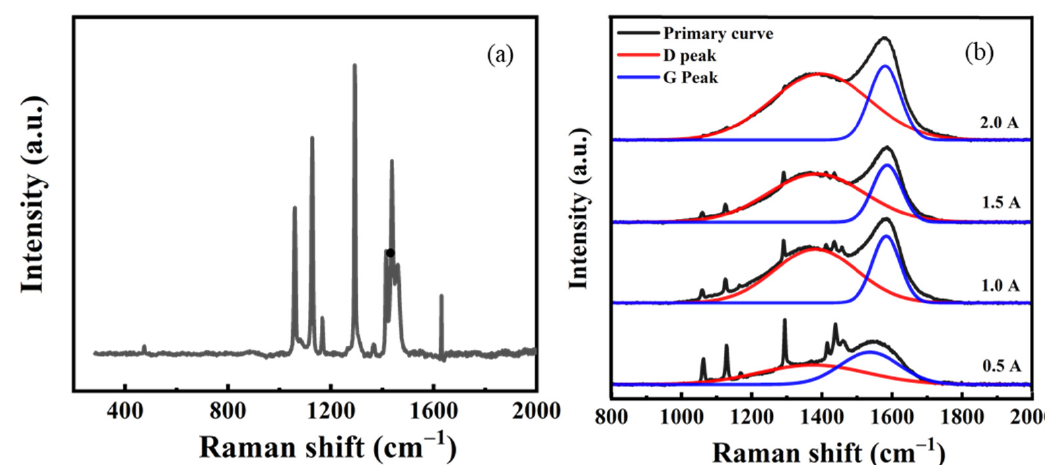
Figure 2. ( a ) Raman spectra of UHMWPE substrates, ( b ) Raman spectra of UHMWPE substrates treated with different carbon plasma currents.